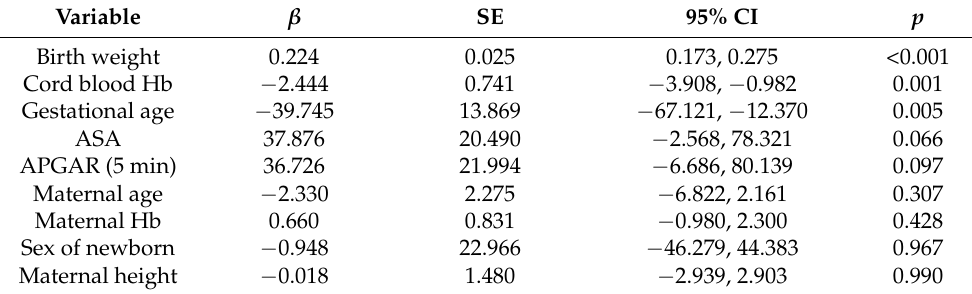
Table 2. Multiple linear regression analysis of placental weight ( r 2 =